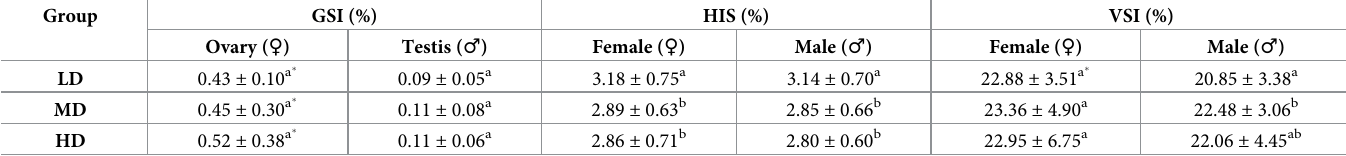
Values are presented as means ± SD. Mean values within the same column with different superscripts are significantly different ( P < 0 . 05 ). While, mean value between female and male within the same group with asterisk is significantly different (P < 0 . 05